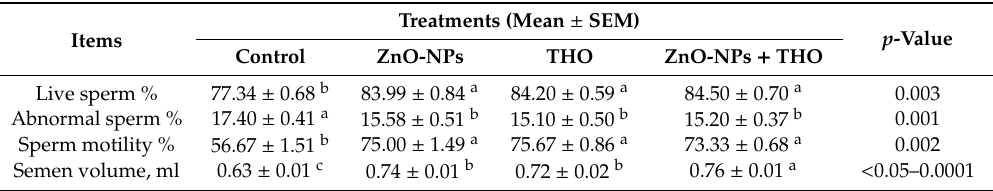
E ff ect of ZnO-NPs, THO and their combination on semen characteristic of male Californian rabbits.